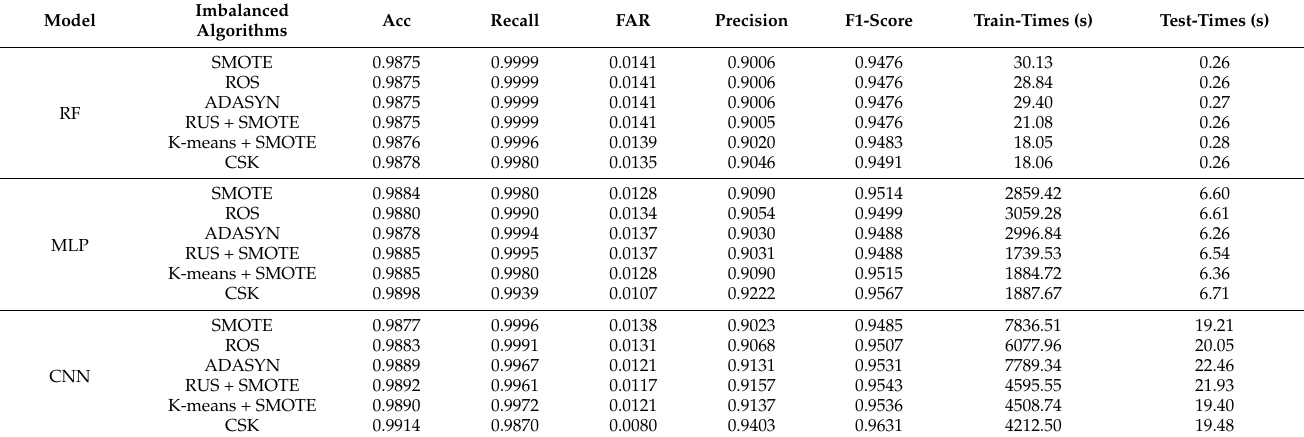
Table 5. Performance Results of Binary Classification on UNSW-NB15